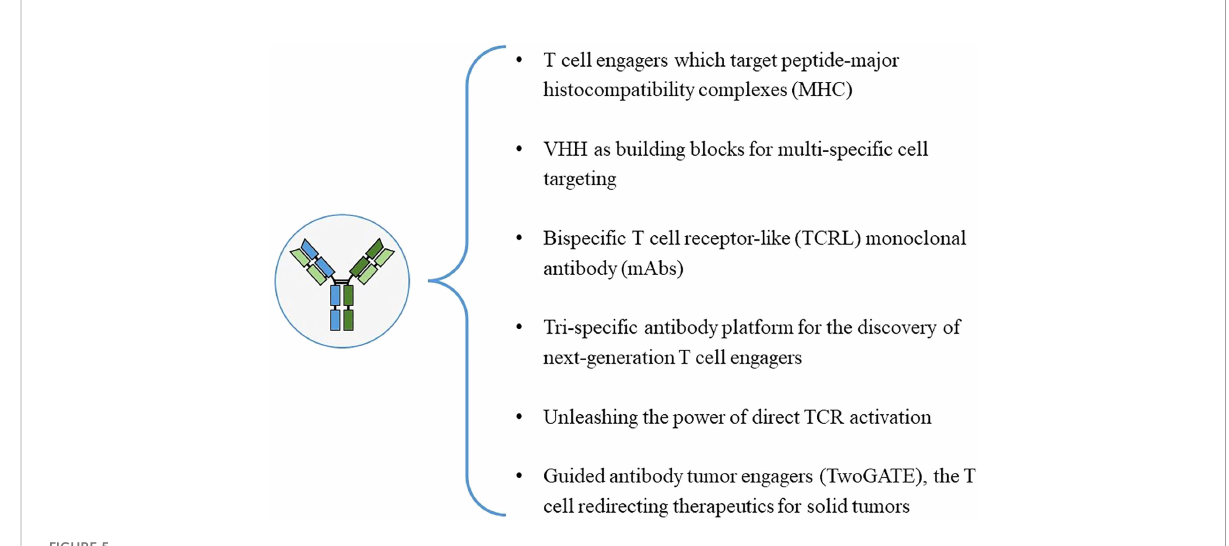
FIGURE 5 The future directions of